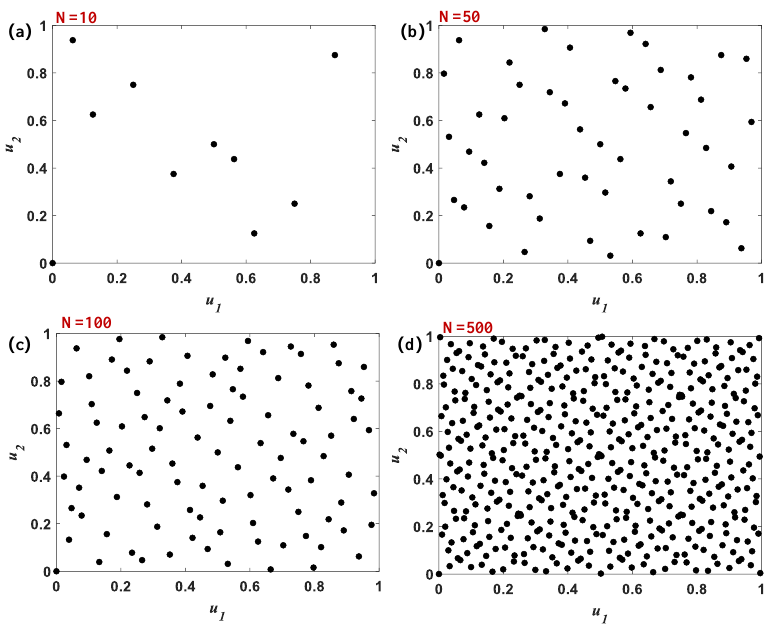
Figure 3. Graphs ( a – d ) represent the sampling numbers of 10, 50, 100, 500 two-dimensional Sobol sampling schematics, respectively. u 1 , u 2 are two parameters in the range